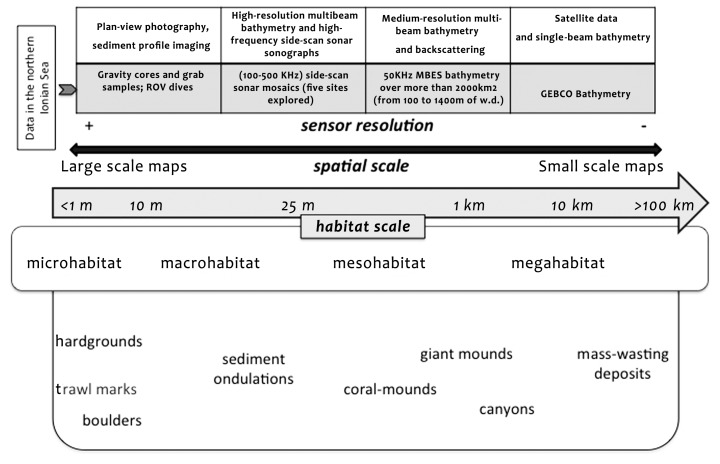
Some typical bathymetric features occurring within the study area, with an indication of their range of dimension.The indicated dimensions are related to the scale of the benthic habitats, the spatial scale of the maps in which they are represented, and the resolution of the sensors used to identify them on the seafloor. Habitat size classes were adapted from Greene et[39].